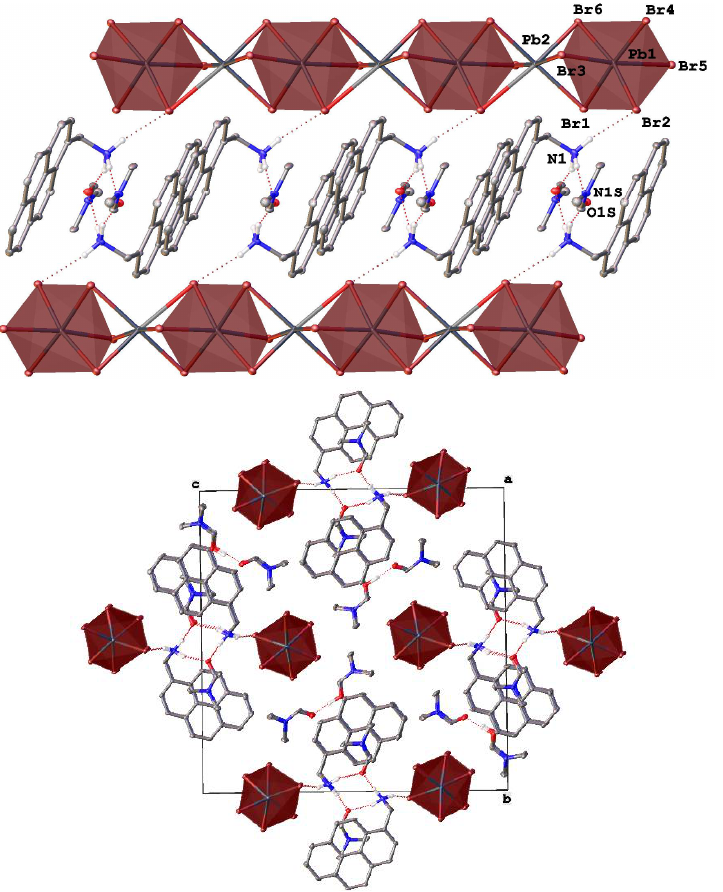
Figure 2. Fragments of the crystal packing in [PyrNH 3 ][Pb 2 Br 6 ][DMFH](DMF) 2 ( a ) illustrating the formation of 1D-infinite chains from lead bromide octahedra (highlighted by pink color) along the crystallographic axis a and ( b ) a view perpen- dicular to this axis. Hydrogen atoms except those of NH 3 groups are omitted for clarity, non-hydrogen atoms are shown as thermal ellipsoids ( p = 30%) and only labels of the heteroatoms in an asymmetric part of the unit cell are